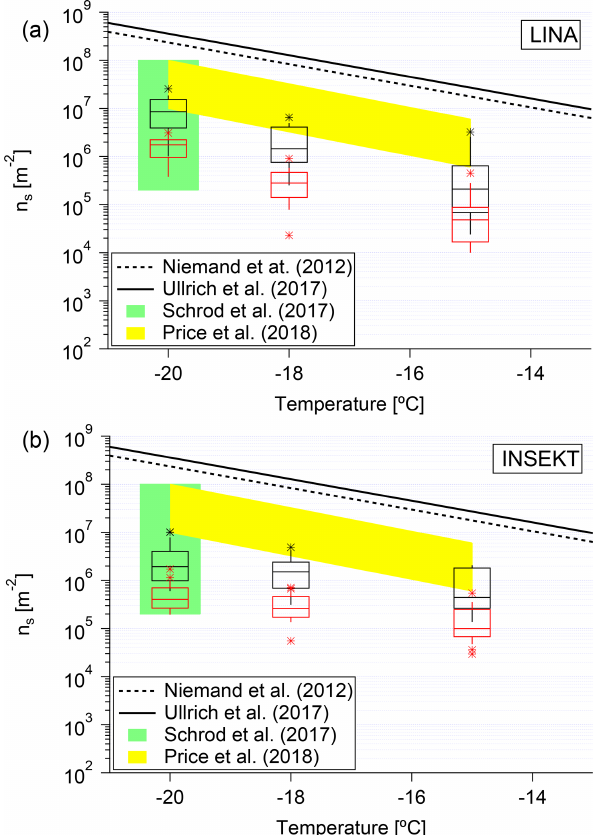
Figure 13. n s > 500nm (black box plot) and n s_all (red box plot) as a function of temperature. The results were determined based on LINA-measured N INP in panel (a) and INSEKT-measured N INP in panel (b) . The boxes represent the interquartile range. Data not in- cluded between the whiskers are plotted as an outlier with a star. Two n s parameterizations (Niemand et al., 2012; Ullrich et al., 2017) for desert dust are shown in dashed and solid line. We also compare this to recent data from airborne measurement by Schrod et al. (2017) and Price et al. (2018), as shown in green and yellow shadow,